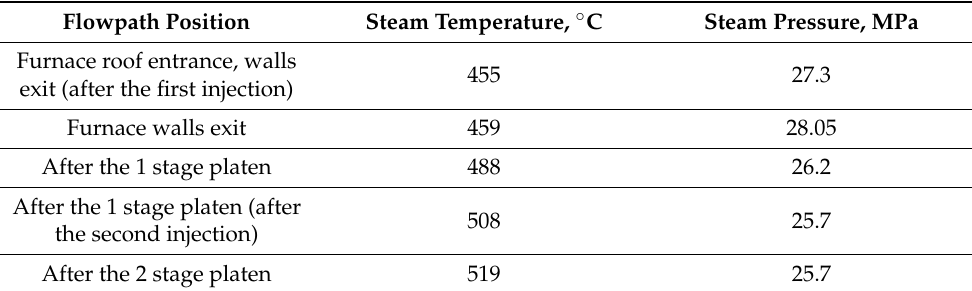
Table 6. Steam parameters in the coal boiler TGMP-312A header pipes.